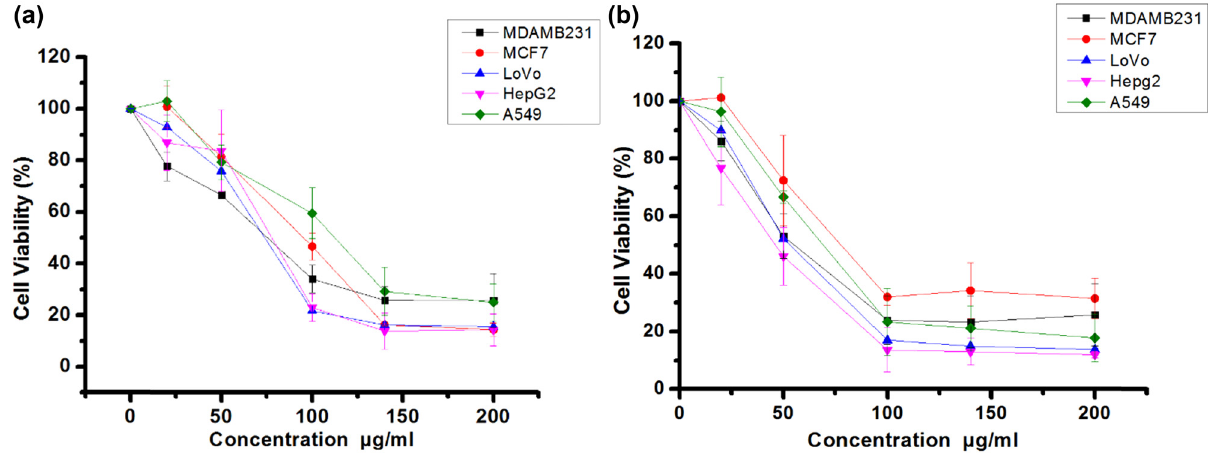
Figure 1: Suppression of viable cancer cell number by propolis methanol extract ( a ) and hexane extract ( b ) against MCF7, MDA - MB - 231, HepG2, LoVo, and A549 cancer cell lines.